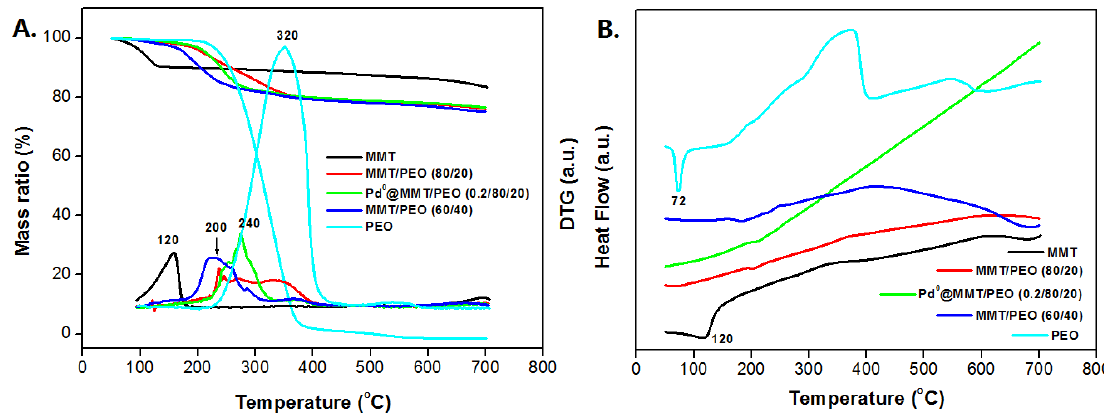
Figure 5. TGA / DTG ( A ) and DSC ( B ) curves of the MMT / PEO hybrids and Pd@MMT / PEO Figure 5. TGA/DTG ( A ) and DSC ( B ) curves of the MMT/PEO hybrids and Pd@MMT/PEO catalytic catalytic composite.